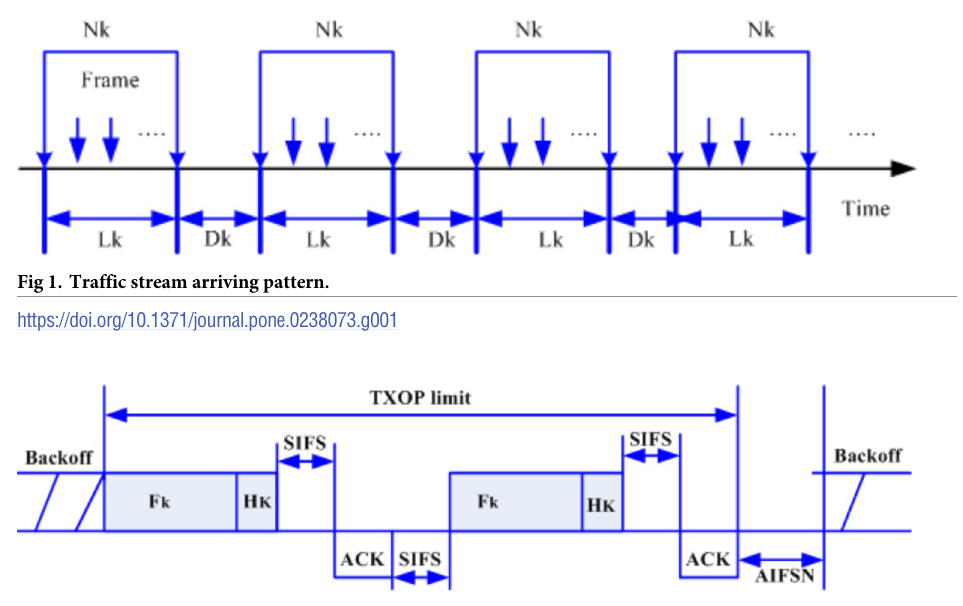
Fig 2. A sample of EDCA frame exchange sequence. Here, F k is the MSDUs size and H k is the MSDUs frame